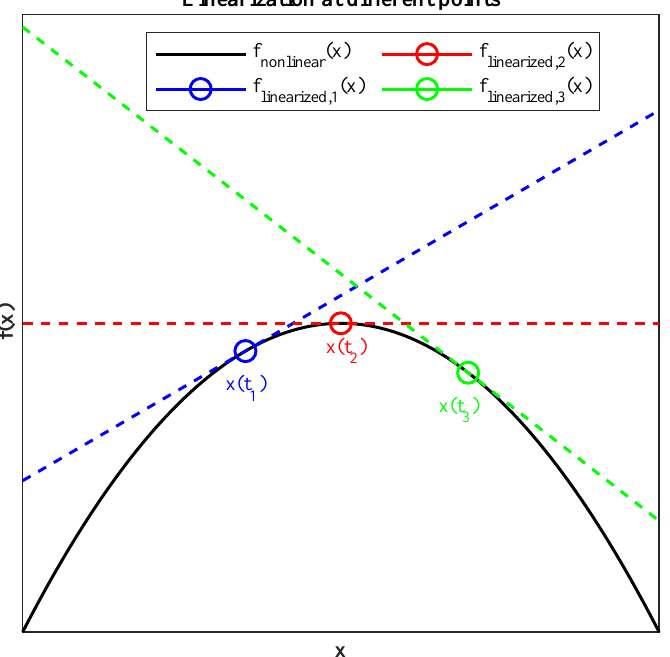
Figure 6. Successive linearization concept. The system function f ( x ) is linearized around the state vector x (t) at every time step. The linearized system is used to develop the MPC at that time